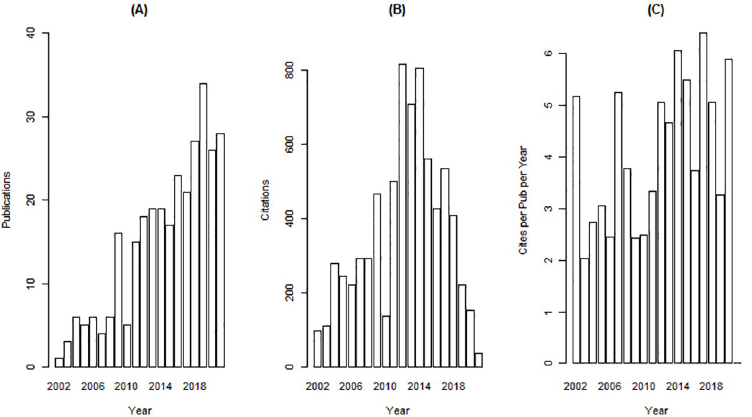
Fig 2. Number of articles and citations of on the socio-demographic dimensions of wildfire by year. A) Publications per year, B) Citations per year, C) Citations per publication per year.